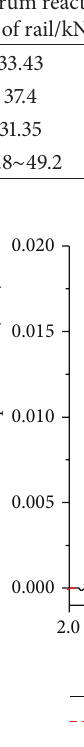
Figure 7: Time history of vertical relative displacement between slab and support layer.